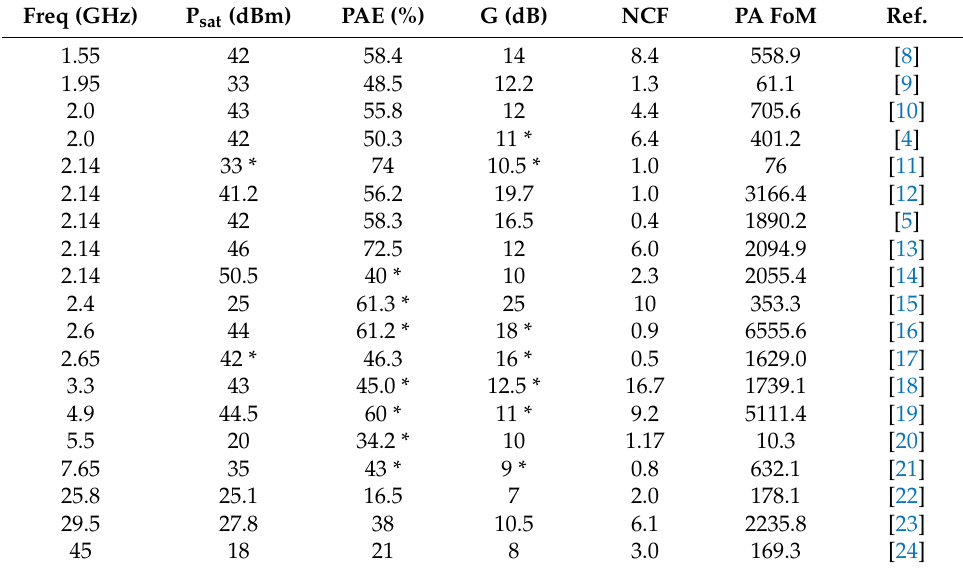
Table 3. Reported DPAs with PA FoM and normalized complexity